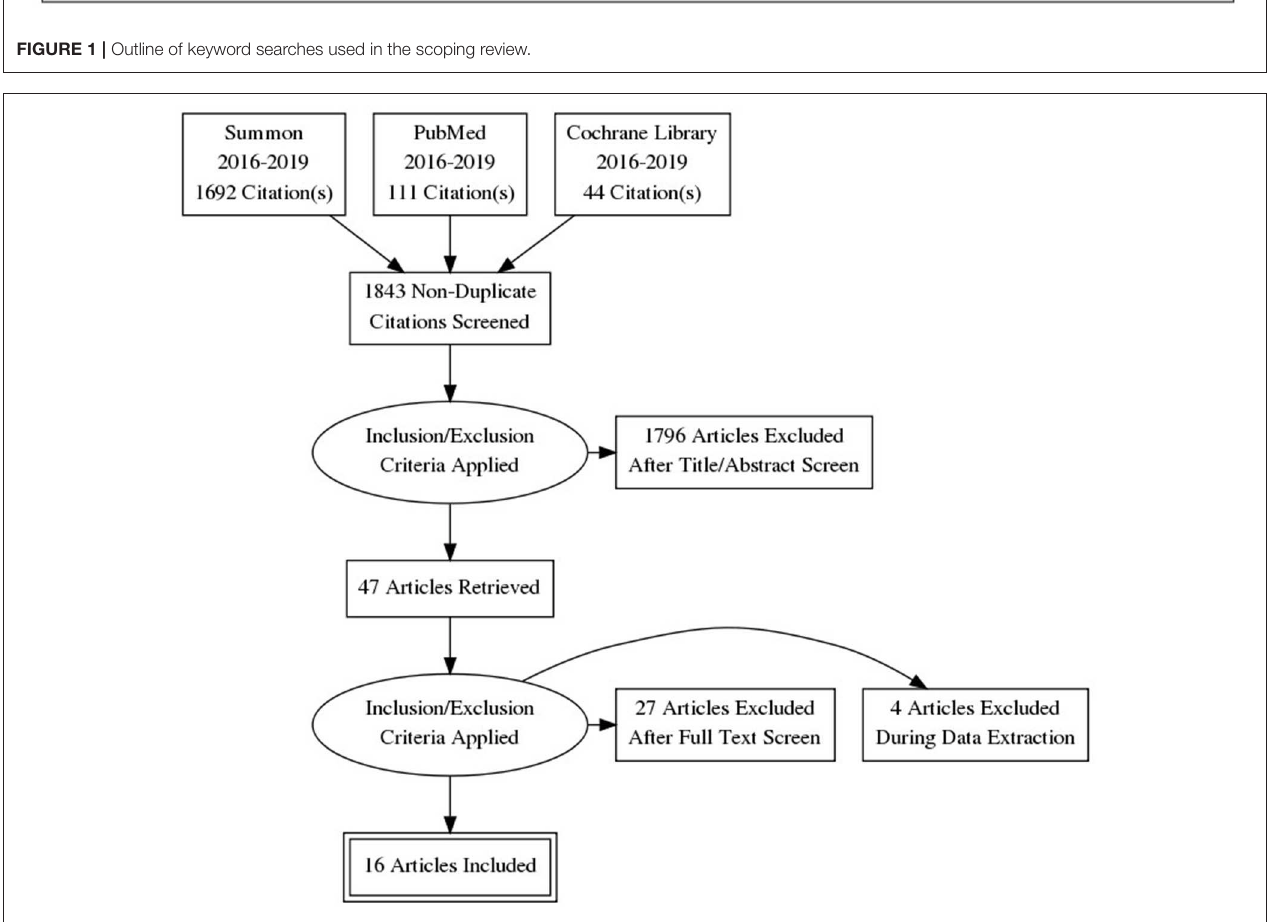
FIGURE 2 | Flow of information through the different phases of a scoping